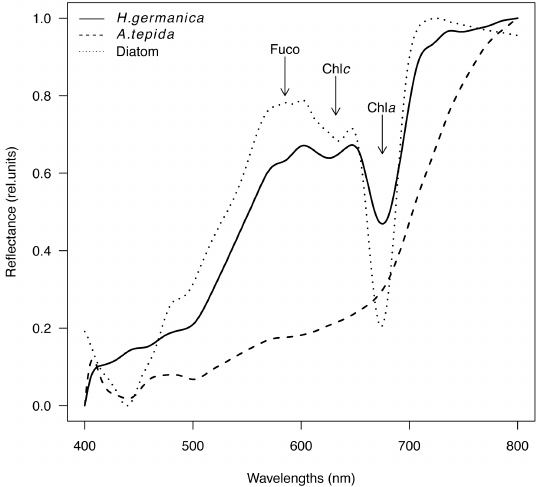
Figure 1. Spectral reflectance signatures of Haynesina germanica , Ammonia tepida and of a benthic diatom in relative units ( x axis legend: Wavelength (nm)).